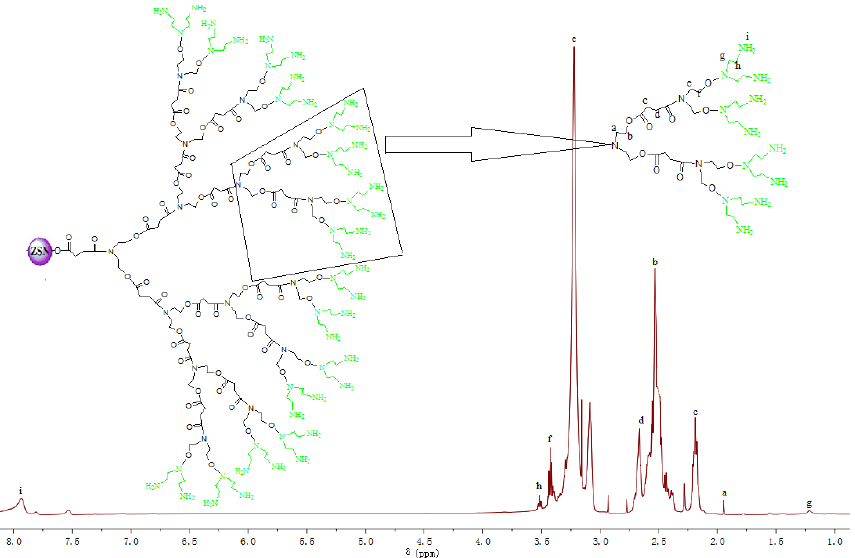
Figure 2. 1 H NMR spectrum of CSPs.